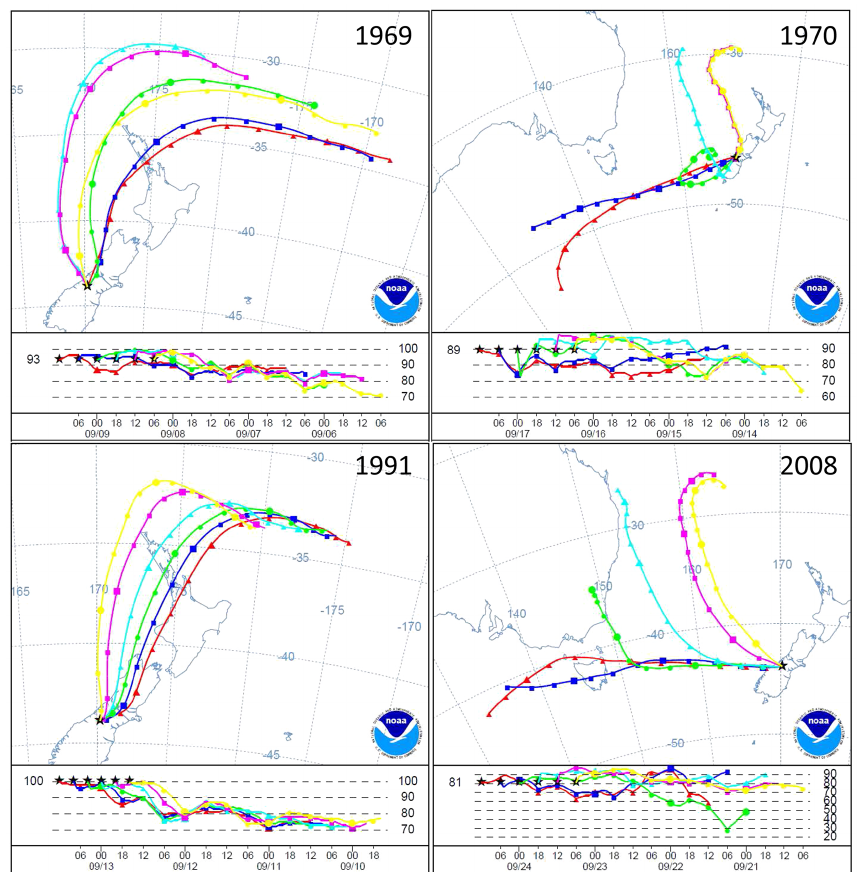
Figure 3. 72h trajectories for the top four September inflow events (dates are the same as Fig. 1). The red line indicates the trajectory started at midnight at the end of the day of each event; the five further trajectories were started at four-hour intervals preceding this (with the earliest trajectory indicated by the yellow line). For each year, the upper section indicates the path of the trajectory and the lower section indicates the relative humidity (%) from the start of the